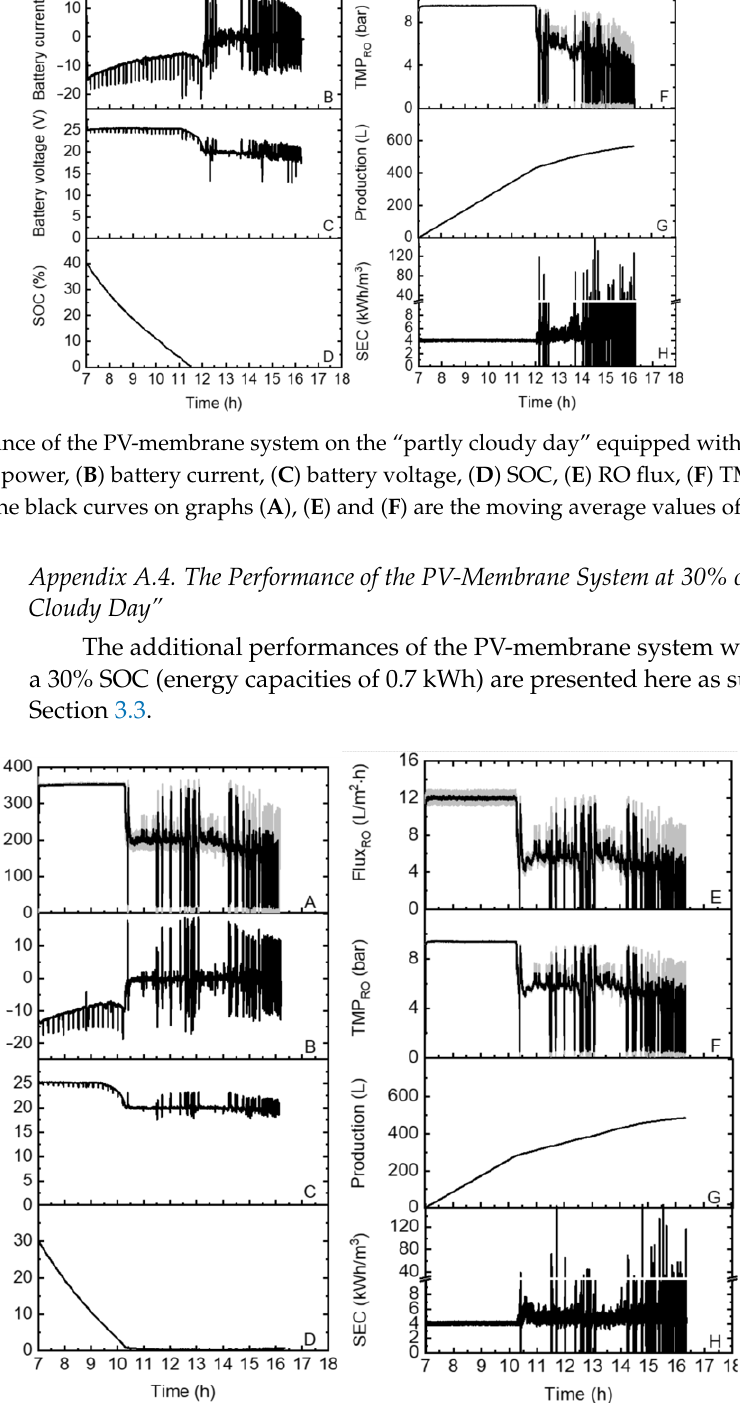
Figure A4. The performance of the PV-membrane system equipped on the “partly cloudy day” with batteries at 30% SOC, indicating ( A ) the motor power, ( B ) battery current, ( C ) battery voltage, ( D ) SOC, ( E ) RO flux, ( F ) TMP RO , ( G ) production and ( H ) SEC. Note that the black curves on graphs ( A ), ( E ) and ( F ) are the moving average values of 10